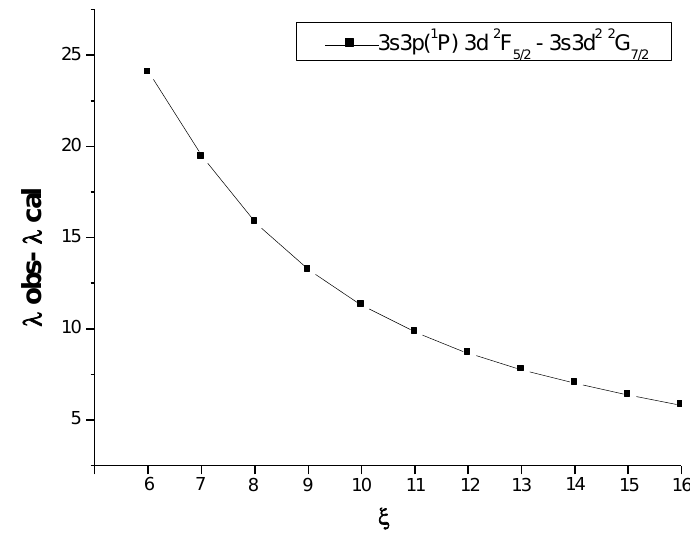
Figure 5. λ obs – λ cal versus the net charge for the 3s3p( 1 P)3d 2 F 5/2 –3s3d 2 2 G 7/2 transition in the Al I sequence. Reproduced by permission of IOP Publishing from [48]. (© The Royal Swedish Academy of Sciences. All rights reserved.)